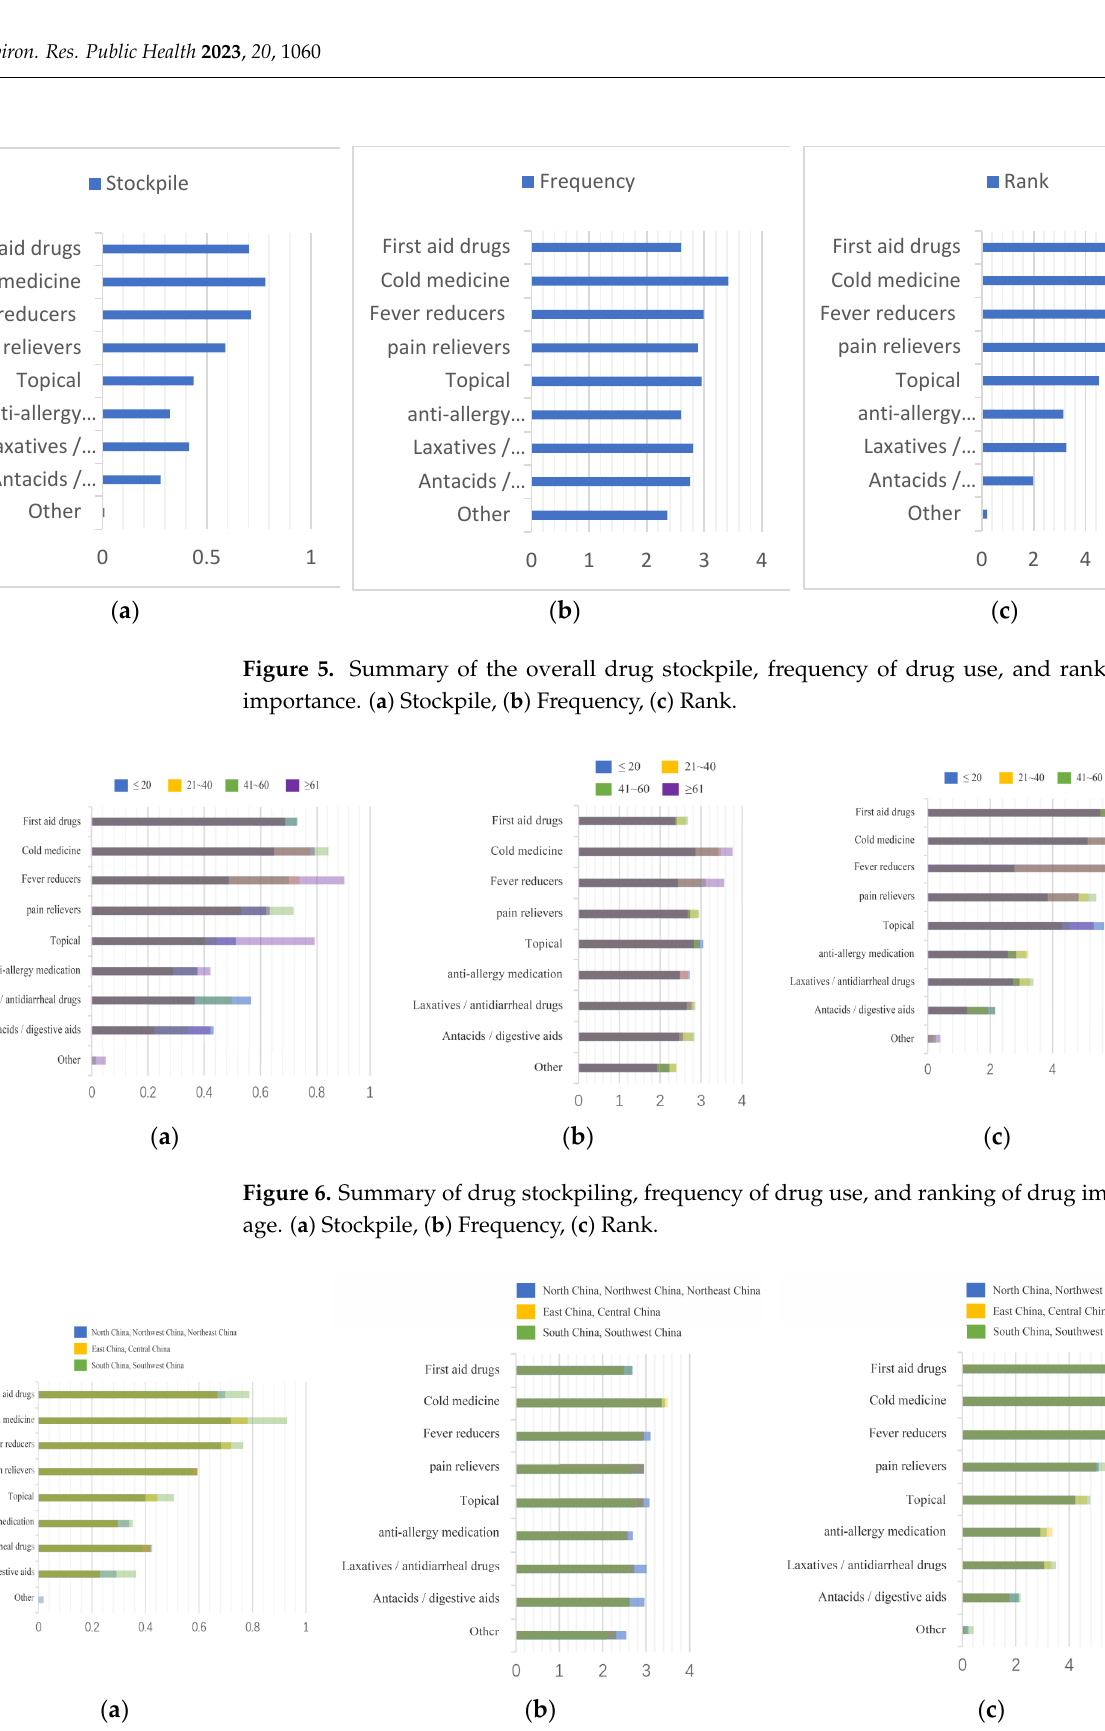
( c ) Figure 8. Summary of drug stockpiling, frequency of drug use, and ranking of drug importance for different number of people living together. ( a ) Stockpile, ( b ) Frequency, ( c ) Rank. ( a ) ( b ) ( c ) Figure 9. Summary of the child-specific medication stockpile, frequency of medication use, and ranking of medication importance for the child’s family. ( a ) Stockpile, ( b ) Frequency, ( c ) Rank. 0